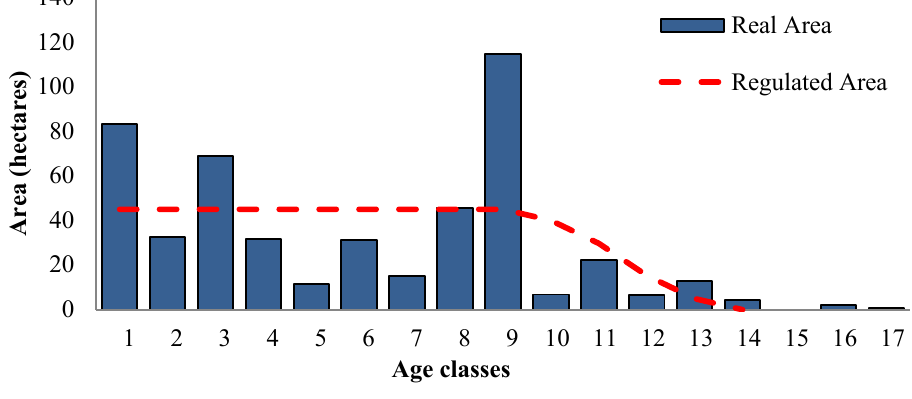
Figure 6. The real and regulated areas of 10-years age classes for FMA (forest management area). All the selected forest stands were divided into the potential harvest units by using the Editing Tool of Optimal (Figure 7). The maximal width of clear-cut (50 m), the minimal width of clear cut (25 m) and the maximal area of clear cut (1 hectare) were defined.